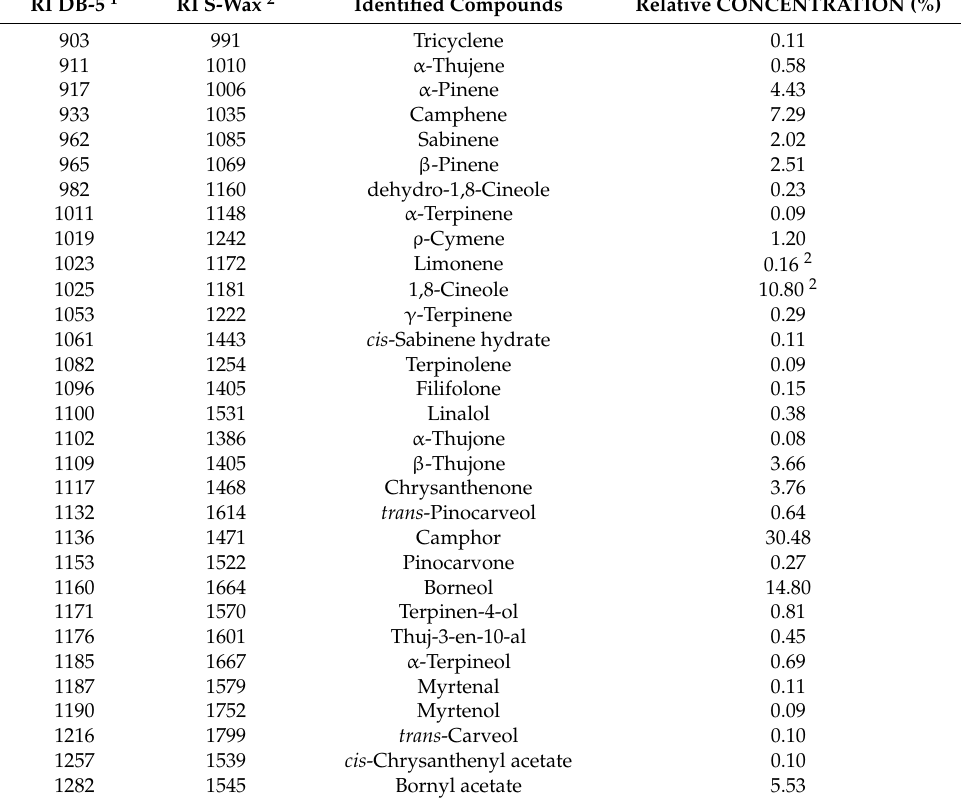
Table 1. Chemical composition of T. vulgare essential oil from northern Quebec,